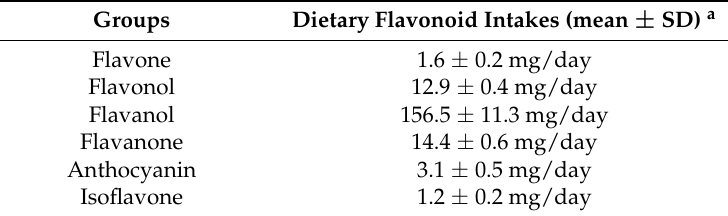
Table 1. Flavonoid intake of U.S. adults aged 19+ y based on the NHANES 1999–2002